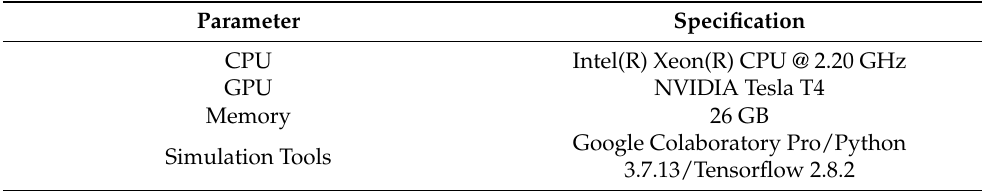
Table 2. Simulation environment.